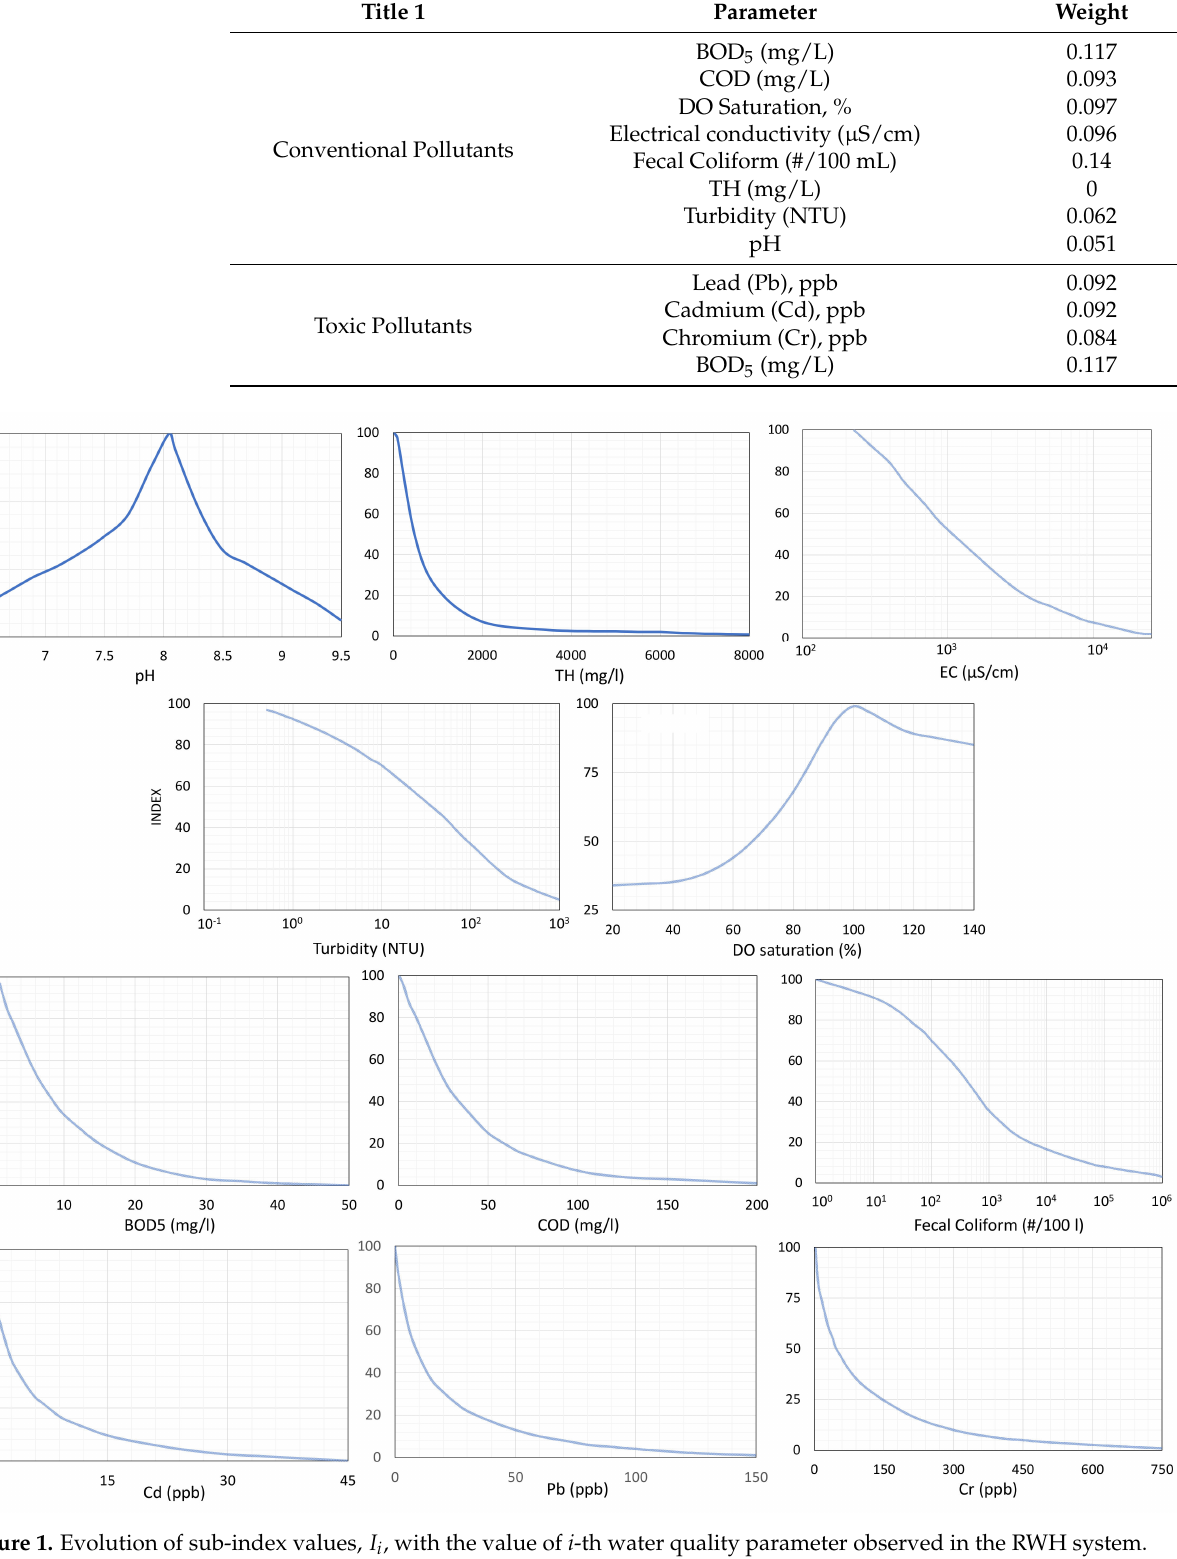
Table 2. Selected parameters and the related weights for the assessment of conventional water quality and toxic pollution of the harvesting water.